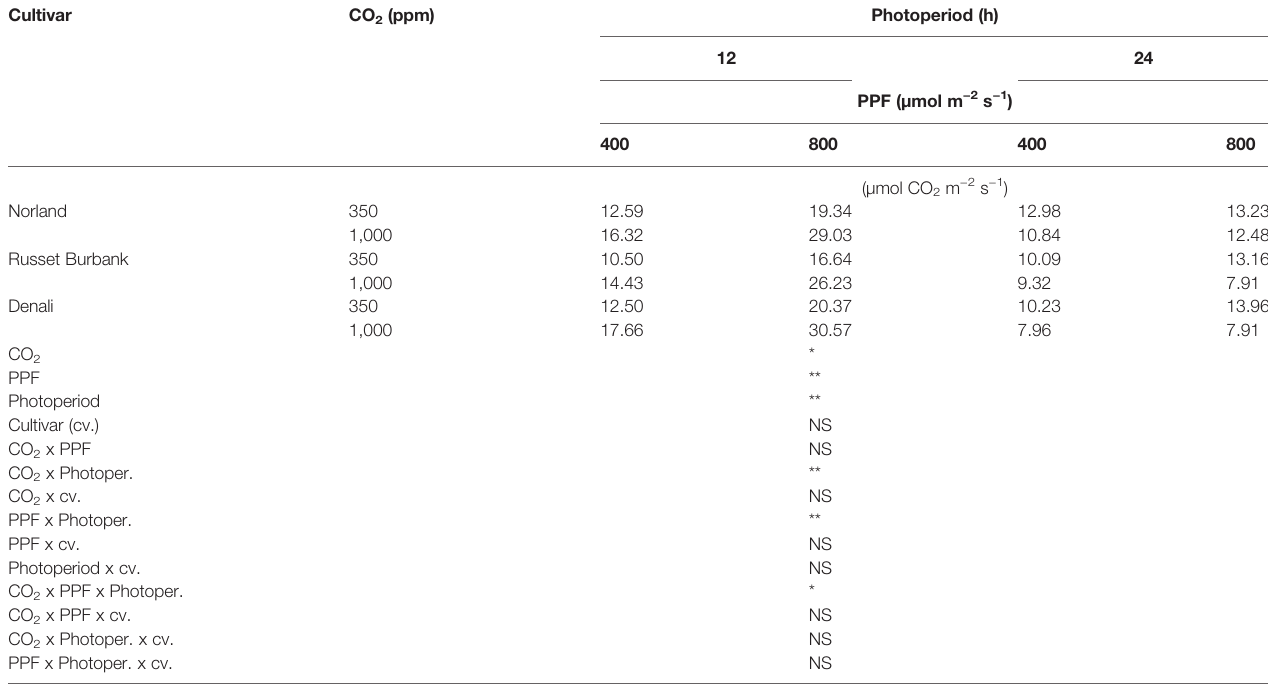
TABLE 1 | Net photosynthetic rates of potato leaves under different photoperiods, CO 2 , and photosynthetic photon fl ux levels (28 days after planting). Cultivar